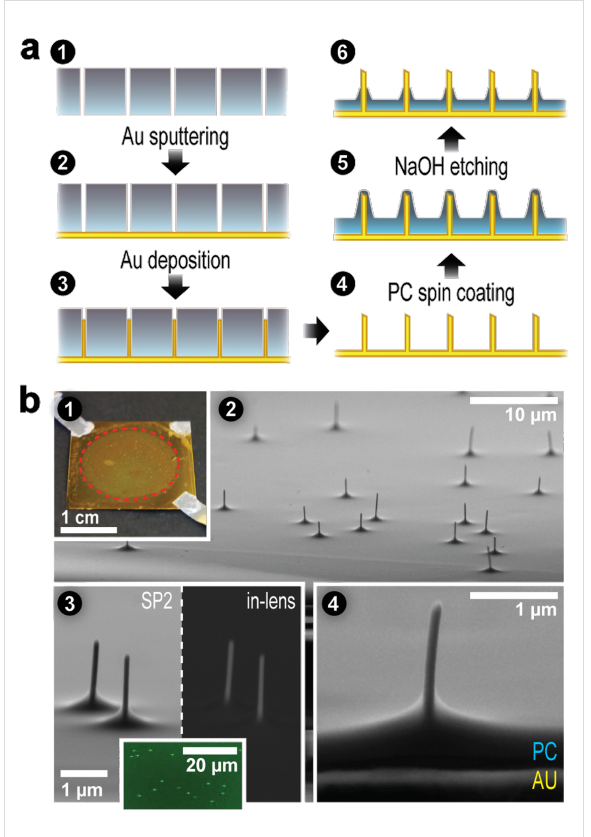
Figure 1: (a) Fabrication of nanoelectrode interfaces (NEIs). Track- etched, polycarbonate (PC) filter membranes (a, 1) are sputter-coated with a gold layer and applied to titanium/gold coated coverslips (a, 2). During wet chemical electrodeposition, monocrystalline gold pillars grow within the filter pores (a, 3). After dissolving the filter membrane using dichloromethane (DCM), free-standing electrodes (a, 4) are covered with a layer of PC via spin-coating (a, 5). Brief etching with NaOH finally exposes the electrode tips (a, 6). (b) Ultrastructural analy- sis of NEIs. A photograph of a final NEI including the attached Al contacts is shown in (b, 1). SEM analysis of the respective surfaces shows that the 1.57 cm 2 deposited area (red dotted line) is covered with partly isolated gold electrodes (b, 2). The electrodes have an av- erage diameter of 102 ± 12 nm and length of 2 ± 0.3 µm (b, 3). Corre- sponding images with the in-lens detector provide increased material contrast to highlight the nonisolated electrode tips (b, 3, right). The accessibility of the gold surface is proven by fluorescence microscopy analysis of NEIs in which gold was labeled by a biotin- and Alexa- Fluor488-labeled streptavidin (b, 3, inset). A SEM side view obtained at a centric braking edge reveals the composition of the interface illus- trating gold pillars protruding from the isolating PC layer (b,